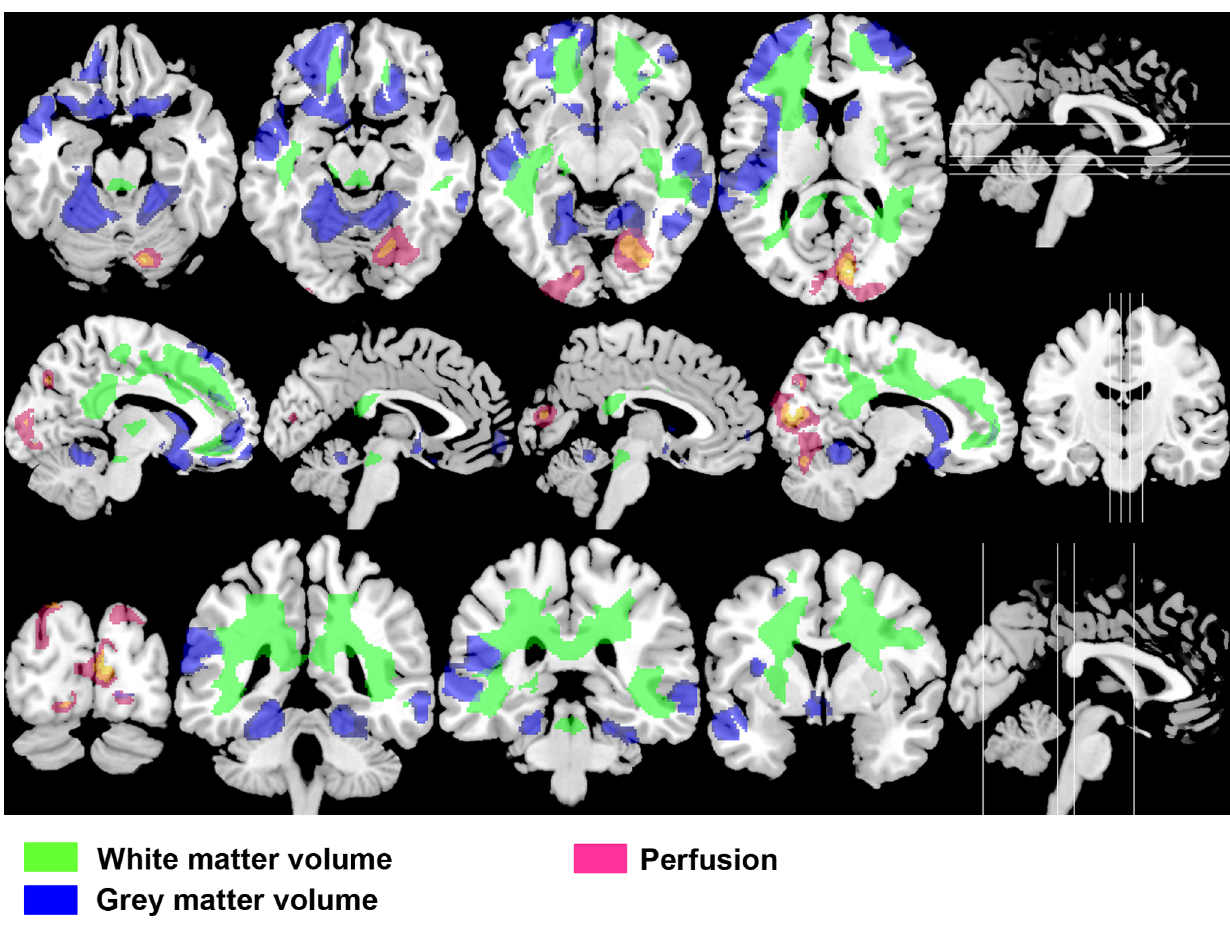
Figure 1. Multimodal negative correlation pattern with the number of optic neuritis attacks in RNMO patients. Axial, sagittal and coronal selected slices at four brain levels (levels shown as white lines in the figures on the right side), presenting overlays of negative correlation statistical parametric maps of white matter volume (in green), grey matter volume (in blue) and perfusion (in pink) on a T1-weighted high resolution MRI template. Decreases of tissue volumes and perfusion with the increase of the number of optic neuritis attacks comprised extensive brain regions, including important components of the visual system such as posterior thalamic radiations (white matter volume), middle and superior temporal gyri (grey matter volume) and the primary visual area (perfusion). Also note that tissue volume decreases included regions close to periaqueductal areas. Statistical parametric maps were thresholded at p value , 0.01 (p value , 0.05 corrected for multiple comparisons at the cluster level).